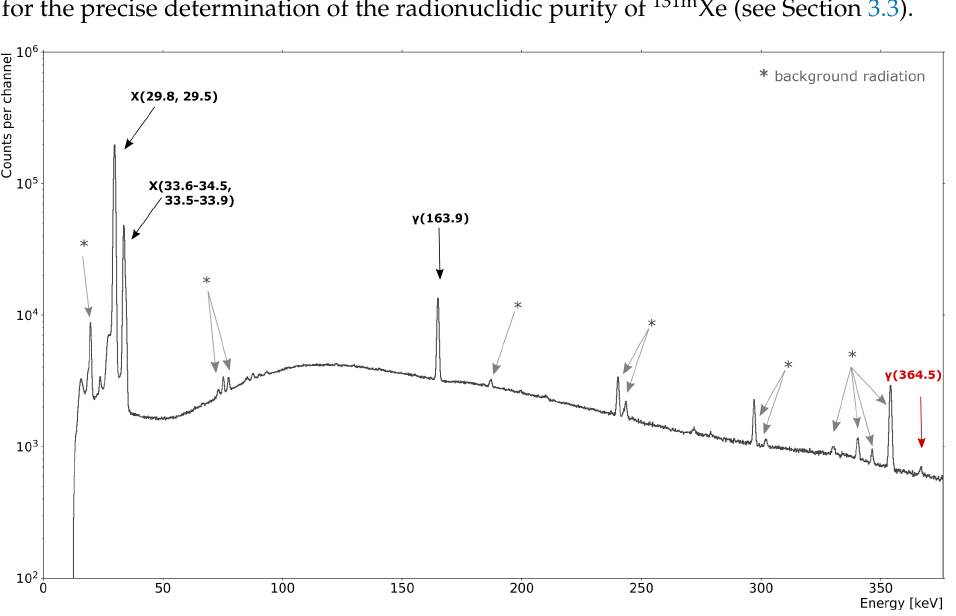
Figure 7. γ -ray spectrum of the collected 131m Xe sample, recorded in the ISOLDE experimental hall. The decay radiation characteristic of 131m Xe is labelled in black. The γ -ray transition is at 163.9 keV (1.95%). The X-rays are at: 29.8 keV (29.3%), 29.5 keV (15.8%), 33.6–34.5 keV (10.5%), 33.6–33.9 keV (8.5%). The main γ -ray peak of 131 I decay (364.5 keV) is labelled and marked in red. The background γ radiation is marked with grey stars.